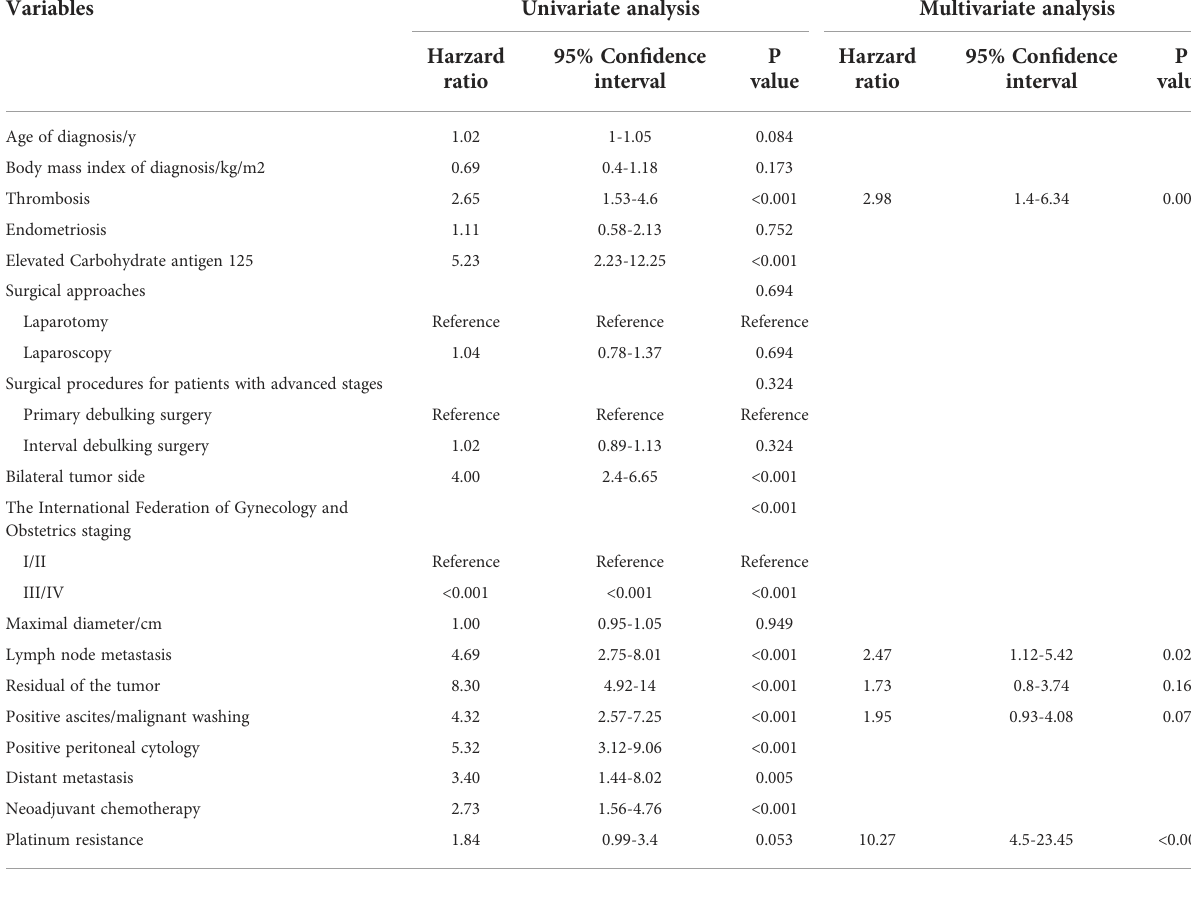
TABLE 3 Overall survival of patients with ovarian clear cell carcinoma.